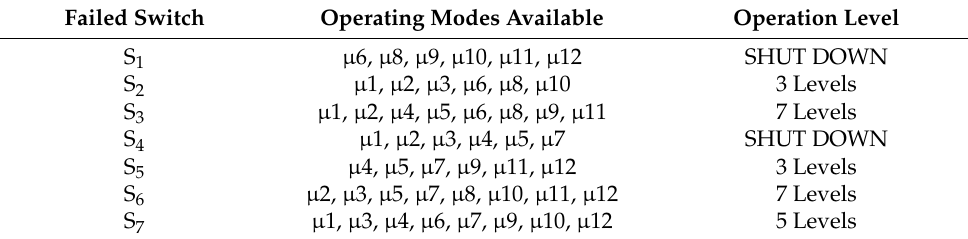
Table 2. Operating modes for single-switch open-circuit fault in existing PEC9 MLI. Failed Switch Operating Modes